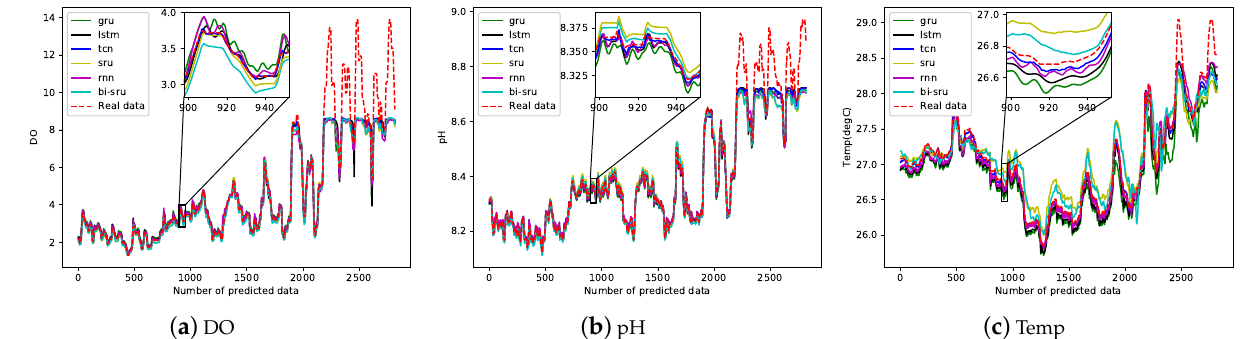
Figure 5. Comparison of real and predicted values in different prediction models: ( a ) dissolved oxygen, ( b ) pH, ( c ) water temperature. Table 4. Records of MAE, RMSE and MAPE in long-term prediction. Water